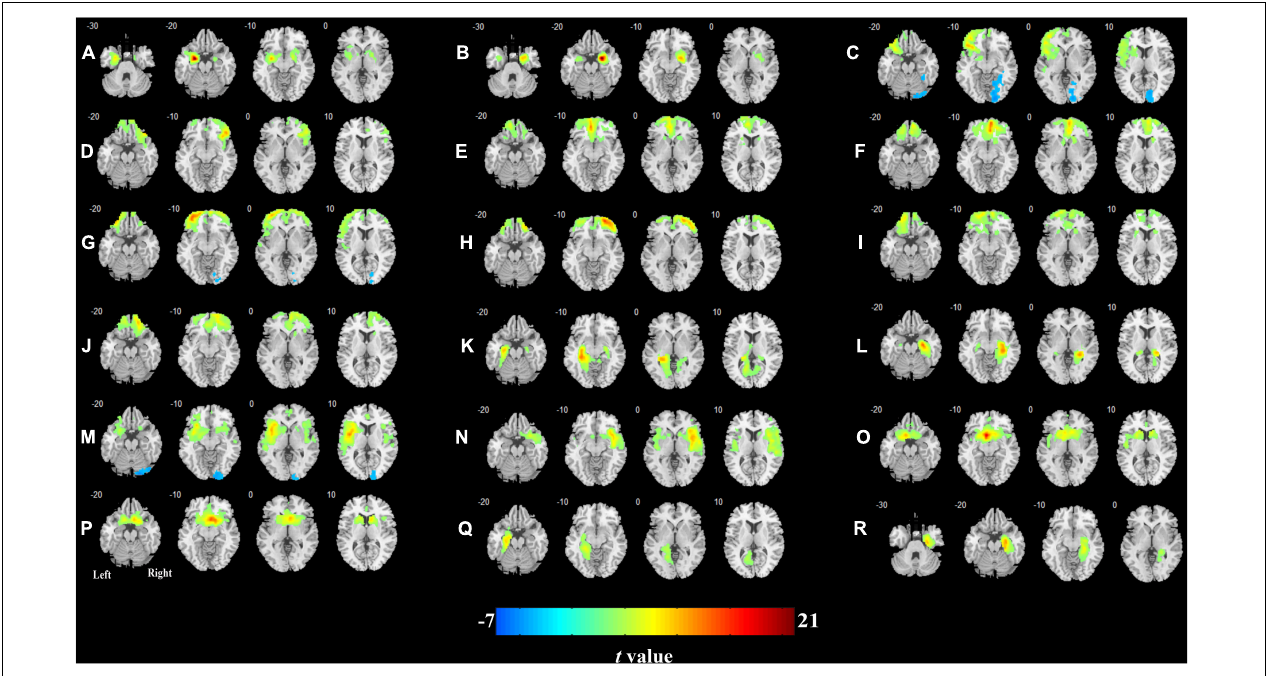
FIGURE 4 | Cerebral blood flow connectivity patterns in olfactory-related brain regions in T2DM. (A) Left amygdala; (B) right amygdala; (C) left orbital part of the inferior frontal gyrus; (D) right orbital part of the inferior frontal gyrus; (E) left medial orbital part of the superior frontal gyrus; (F) right medial orbital part of the superior frontal gyrus; (G) left orbital part of the middle frontal gyrus; (H) right orbital part of the middle frontal gyrus; (I) left orbital part of the superior frontal gyrus; (J) right orbital part of the superior frontal gyrus; (K) left hippocampus; (L) right hippocampus; (M) left insula; (N) right insula; (O) left olfactory cortex; (P) right olfactory cortex; (Q) left parahippocampal gyrus; (R) right parahippocampal gyrus. TABLE 4 | Differences in CBF connectivity in olfactory brain regions between patients with T2DM and HCs. No. Seed regions Differential brain regions Cluster size t- value of the peak point MNI coordinates of the peak point ( x -, y -, z